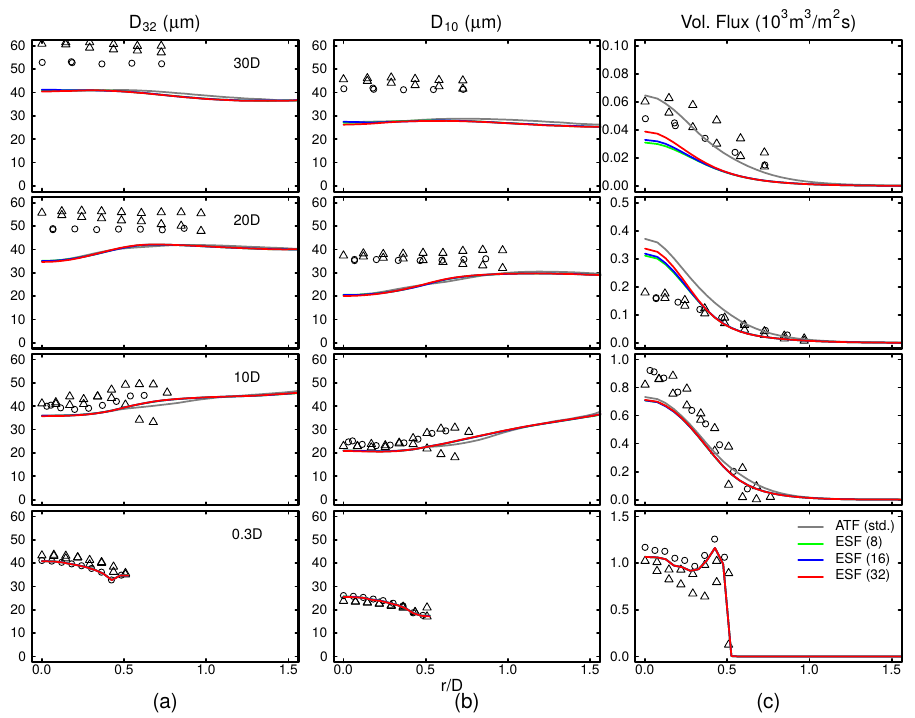
Figure 7. ( a ) Sauter mean diameter D 32 , ( b ) mean diameter D 10 and ( c ) liquid volumetric flux at various axial distances from the burner exit compared with available experimental